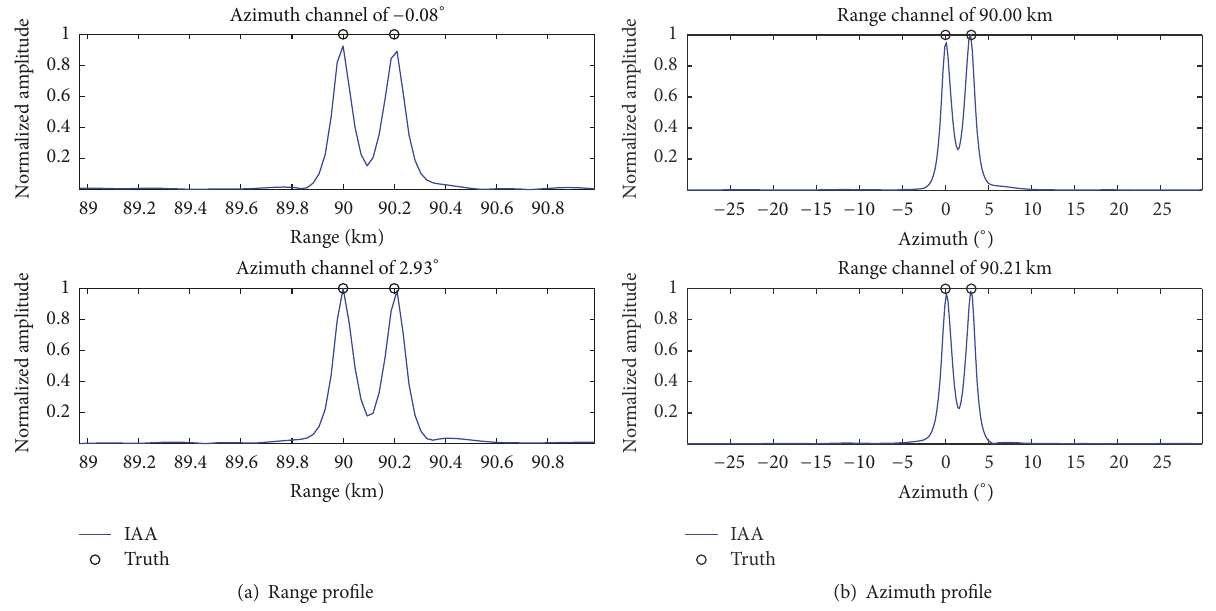
Figure 10: Range and azimuth profile of 2D IAA range-azimuth image at the target positions.